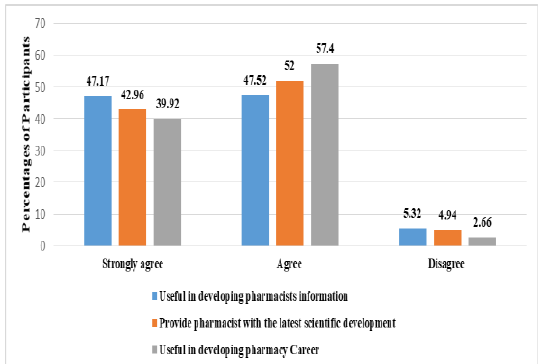
Figure 2. Pharmacists’ opinion about continuing education programs